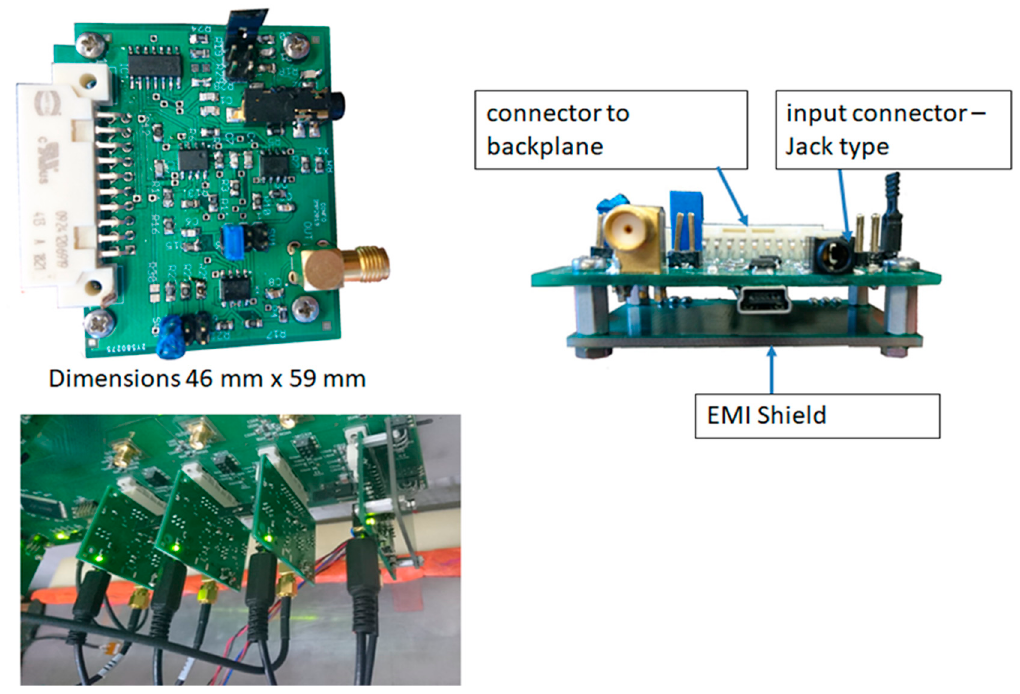
Figure 12. ( Top ) The board with the analog electronic front end. ( Bottom ) Modular installation boards on the backplane of the real-time electronic platform for SHM.